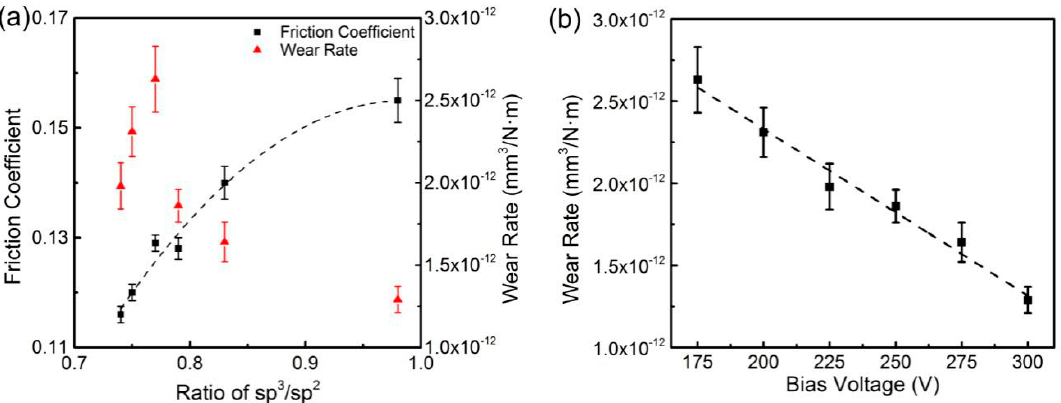
Figure 7. ( a ) Friction coefficients against Si3N4 as a function of ratio of sp 3 /sp 2 and wear rate; ( b ) wear rate against Si3N4 as a function of bias voltage .